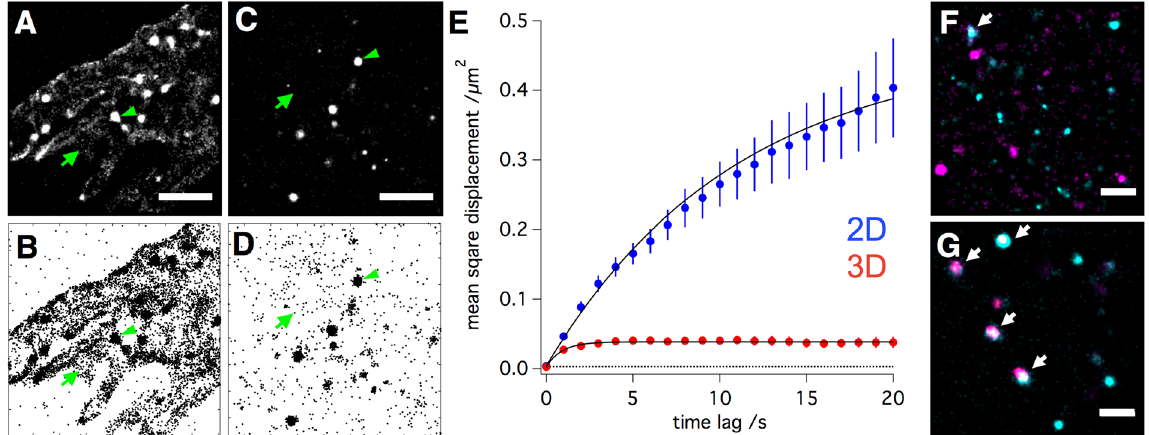
Figure 2. 2D versus 3D cell culture conditions have a strong impact on the nanoscale distribution of integrins. ( A ) Normalised gaussian and ( B ) Scatter plot visualization of single molecule localization data obtained through a live-cell immunostaining of 2D cultured cells with a directly labeled integrin β 1 antibody. Scale bar is 2 µ m. ( C and D ) Corresponding data of a live-cell integrin β 1 immunostaining of 3D cultured cells. A much higher fraction of integrins in 2D cultured cell is not part of a cluster as compared to 3D cultured cells (immobile integrin clusters = green arrowheads, individual mobile integrins = green arrows). Single molecule tracking of live cell antibody stained β 1 integrins confirms this visual observation. Whereas the mean square displacement plot of β 1 integrin mobility measured in 3D cultured cells shows a strong confinement (fast saturation of the curve) and low mobility (low slope, Fig. 2E, red), β 1 integrins in 2D culture cells are, on average, much faster and far less confined in their mobility (Fig. 2E, blue). Fitting both plots to a model for confined diffusion reveals that β 1 integrins in 2D and 3D cultured cells are confined in their mobility to an area of 1.2 ± 0,045 and 0.33 ± 0,005 µ m 2 with diffusion coefficients of 0,02 ± 0,0005 and 0,002 ± 0,0001 µ m 2 /s, respectively. The dotted line represents the lower limit of the detectable square displacement (in our case 4 × (28 nm) 2 = 0,003136 µ m 2 ). ( F ) Colocalization of β 1 (cyan) and β 3 (magenta) integrins in 2D and (G) 3D cultured cells. Scale bar is 1 µ m. Arrows indicate integrin-subunit colocalization (white) of β 1 (cyan) and β 3 (magenta) integrin